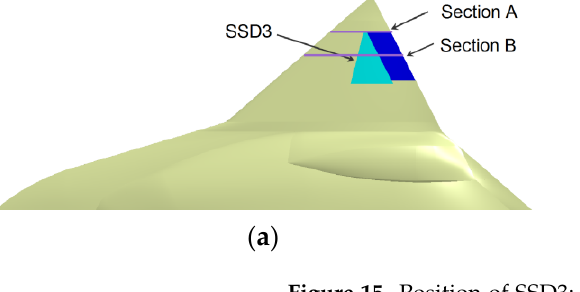
Figure 15. Position of SSD3: ( a ) Section location; ( b ) Locations of the outer end faces of SSD3 on Section A.